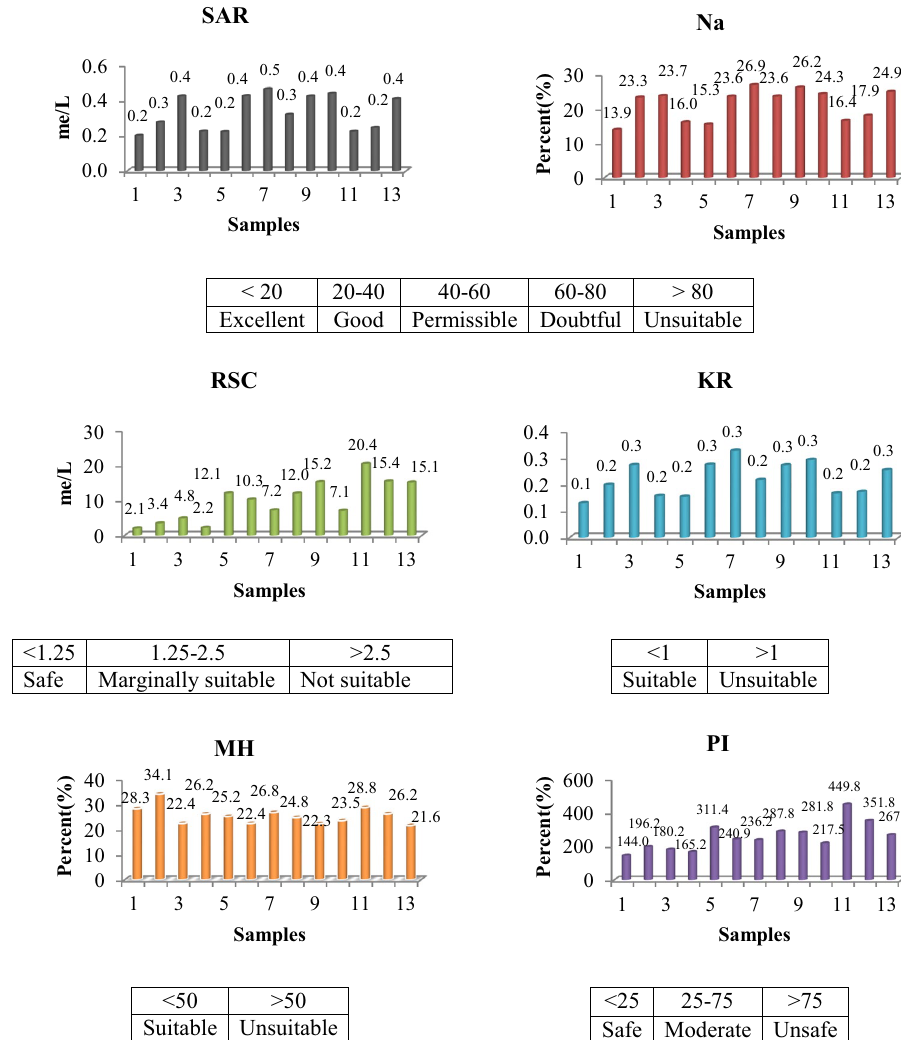
Fig. 2 Variation of SAR, Na, RSC, KR, MH, PI among KWW